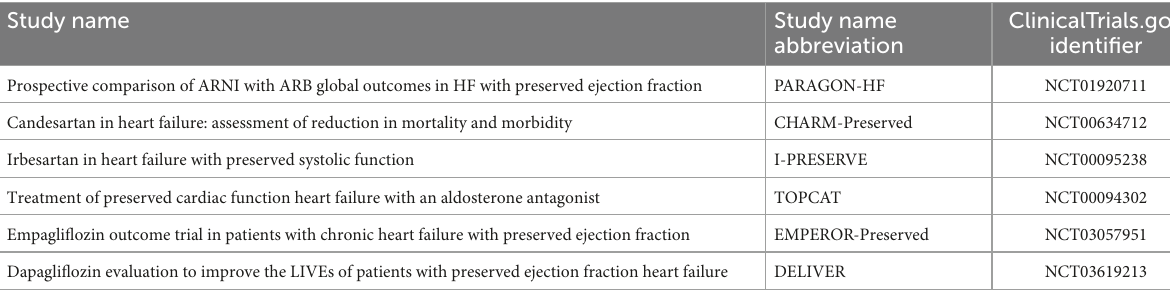
TABLE 1 Key clinical trials of medical therapies for heart failure with preserved ejection fraction (HFpEF) (14).